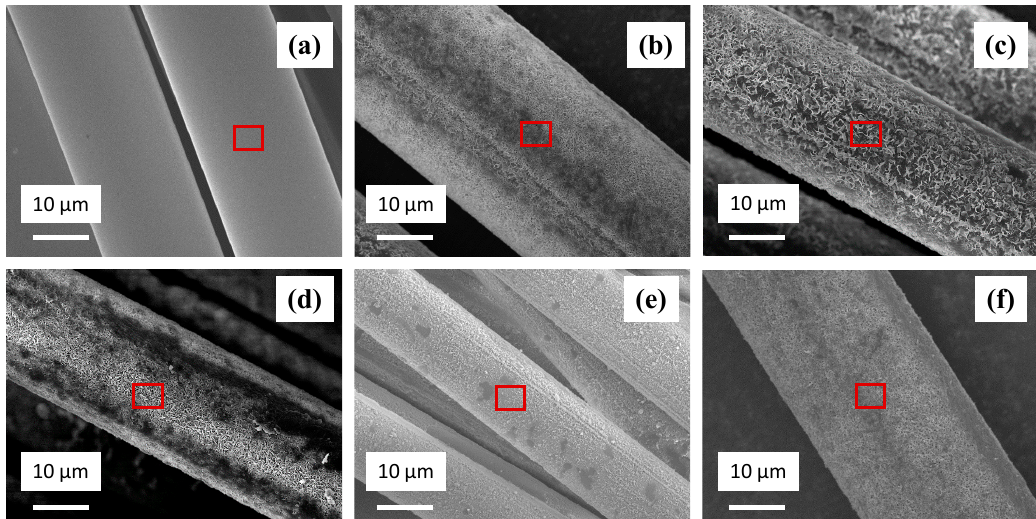
Figure 3. Scanning electron microscopy (SEM) surface morphology of basalt fiber after immersing in seawater solution at 85 °C ( a ) pristine; ( b ) 6 h; ( c ) 12 h; ( d ) 18 h; ( e ) 24 h; ( f ) 168 h.